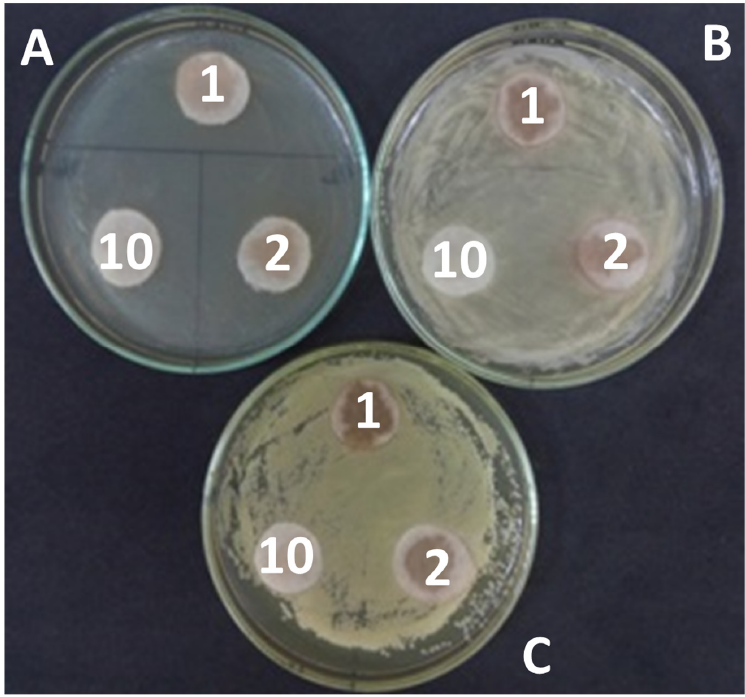
Figure 7. Experiment with bacterial cultures and extract in water at the initial concentration (“1”) and diluted 2 and 10 times (“2” and “10” respectively). ( А )— Micrococcus luteus , ( B )— Pseudomonas fluorescens , ( C )— Bacillus subtilis .